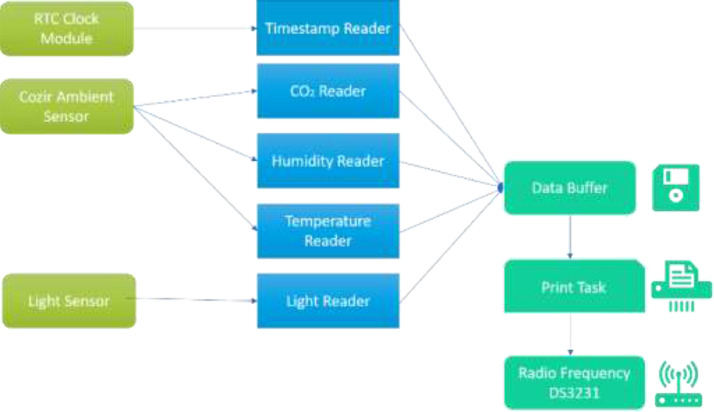
RTOS configuration.